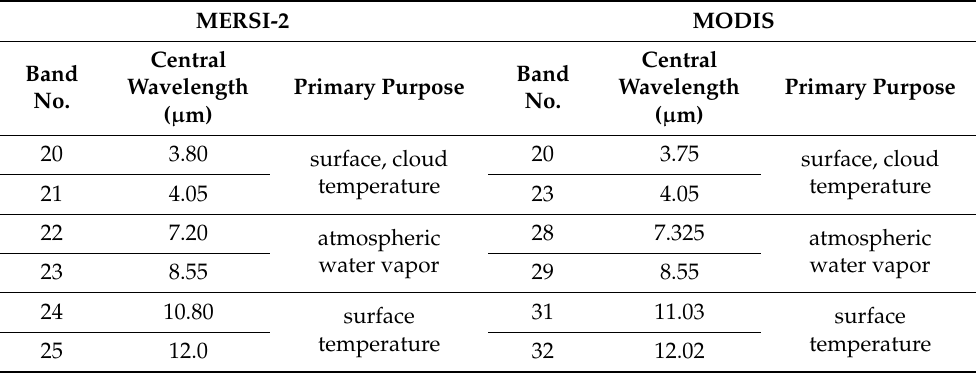
Table 1. Intercomparison of the TIR bands between the MERSI-2 and MODIS payload. MERSI-2 MODIS